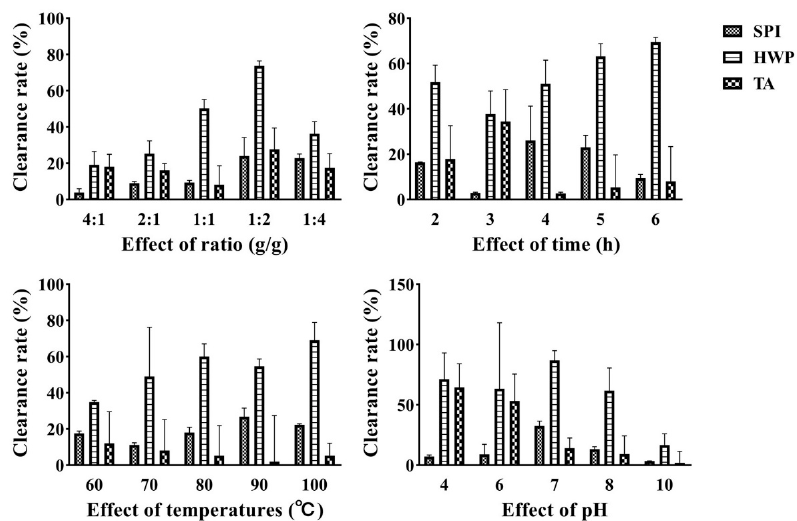
Figure 2. DPPH radical scavenging ability of the complex under different treatment conditions.